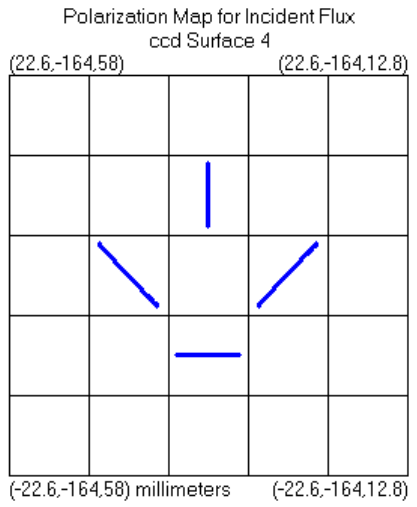
Figure 6. Diagram of the polarization state of the light wave after passing through a polarization array